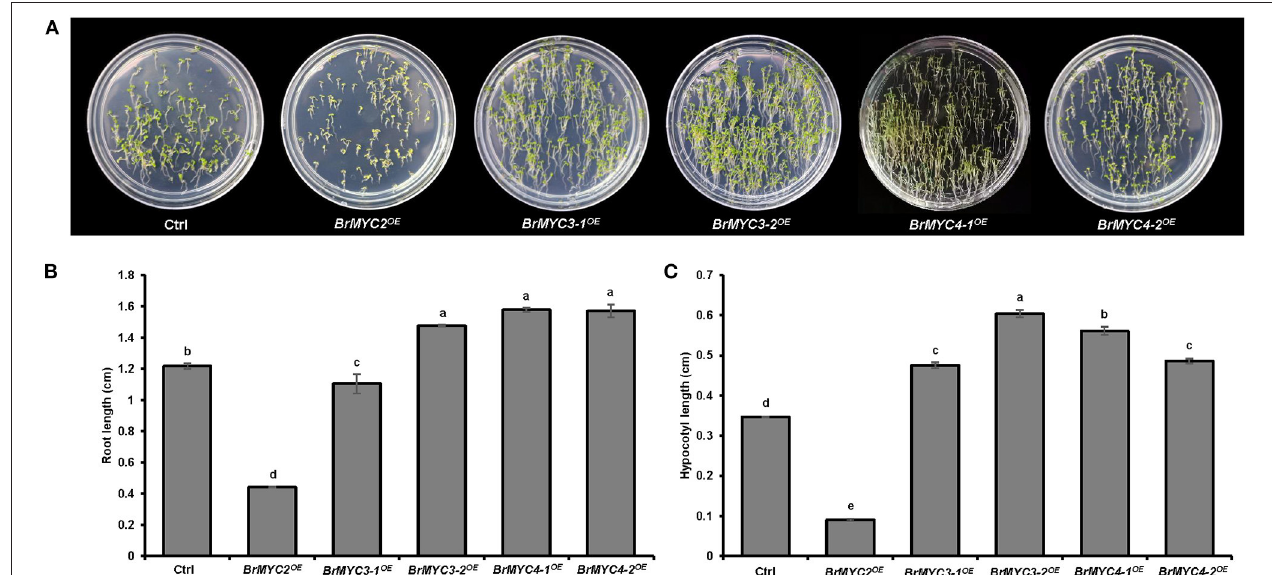
FIGURE 5 | Root and hypocotyl length of T3 Arabidopsis lines transgenic for BrMYC2/3/4 genes. (A) Phenotype of 6-day old seedlings. (B) Comparison of the root length. (C) Comparison of the hypocotyl length. Transgenic lines are Ctrl, BrMYC2 OE , BrMYC3-1 OE , BrMYC3-2 OE , BrMYC4-1 OE , and BrMYC4-2 OE . Data are shown as mean ± SD from three independent biological replicates. ANOVA was used for statistical analysis, followed by Tukey’s multiple comparison test ( p < 0.05). Bar = 1cm.